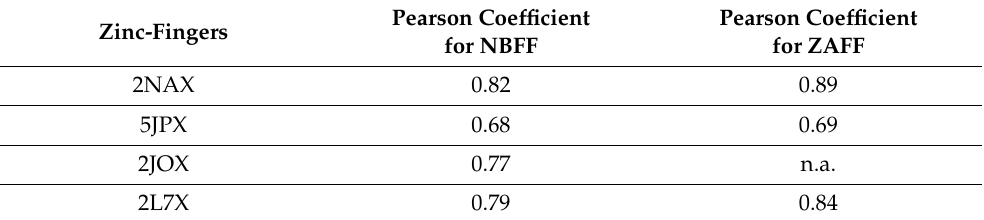
Figure 2. Mean S 2 of 2NAX and standard deviation (SD) for bonded (red) and nonbonded (green) simulations superimposed to Het-NOE data (purple). Orange squares represent the position in the sequence of zinc(II)-binding Cys residues, whereas the green squares represent zinc(II)-binding His residues. Table 1. Pearson coefficients computed for each zinc(II) FF with respect to the Het-NOE data. For 2JOX, it was not possible to apply the ZAFF. 1CHC and 2K9H are not reported since there are no experimental data